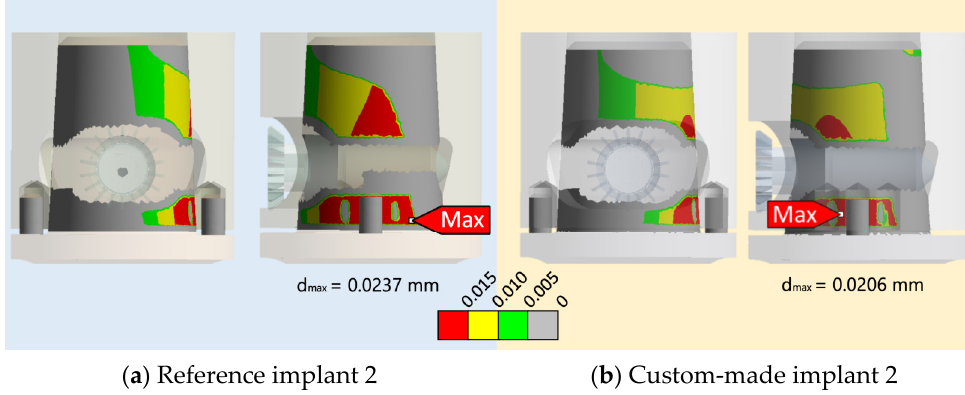
Figure 6. FEA results of reference implant 2 and custom-made implant 2. ( a ) Maximum micromotion (d max ) and micromotion distribution of reference implant 2 and ( b ) custom-made implant 2.